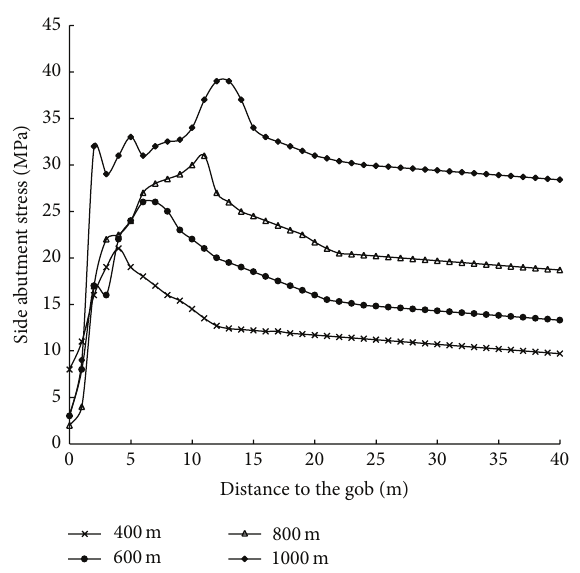
Figure 7: Distribution of the side abutment stress for coal seams with different depth.